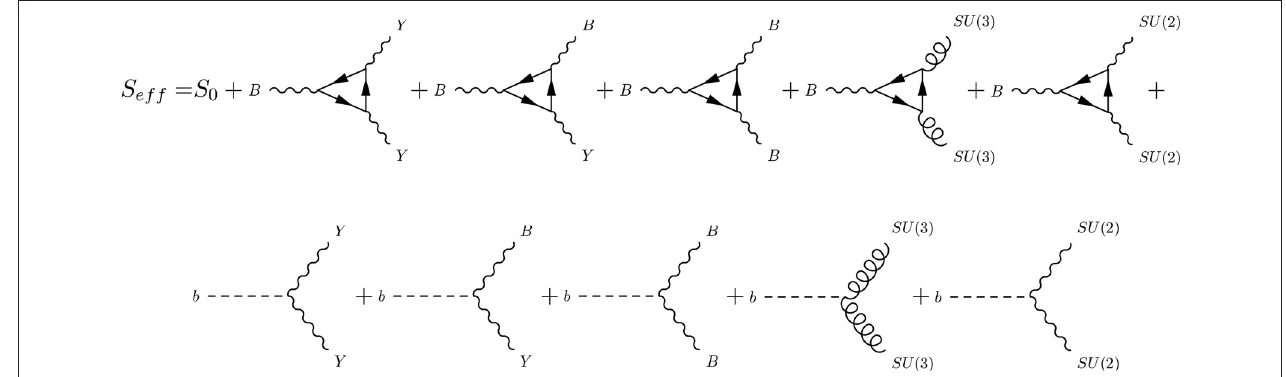
FIGURE 1 | The 1PI effective action for a typical low scale model obtained by adding one extra anomalous U (1) B to the Standard Model action. Shown are the one-loop trilinear anomalous interactions and the corresponding counterterms, involving the b field.